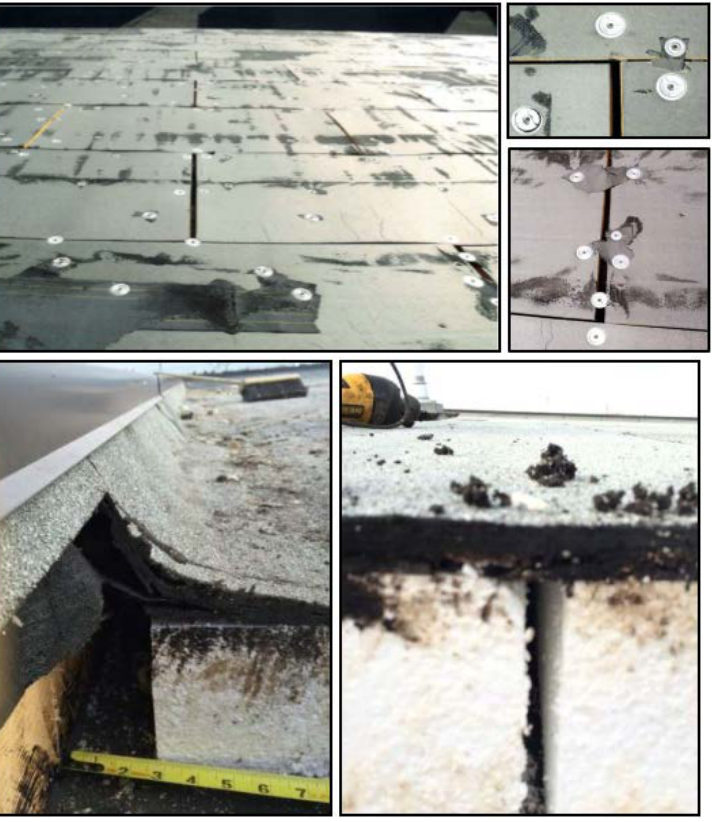
Figure 2. Typical examples of gap formations in low-slope roof assembly (Courtesy: 2001 Company & CRCA).